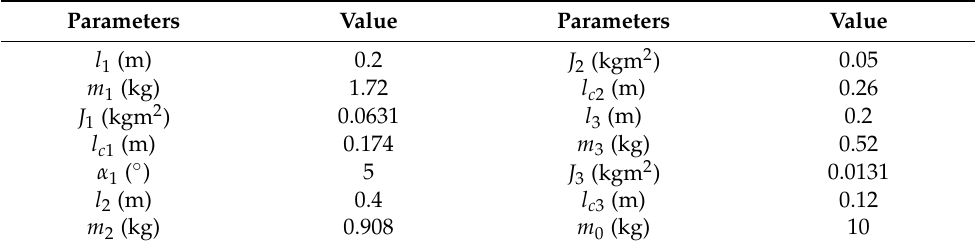
Table 1. Parameters of the kangaroo inspired one-legged